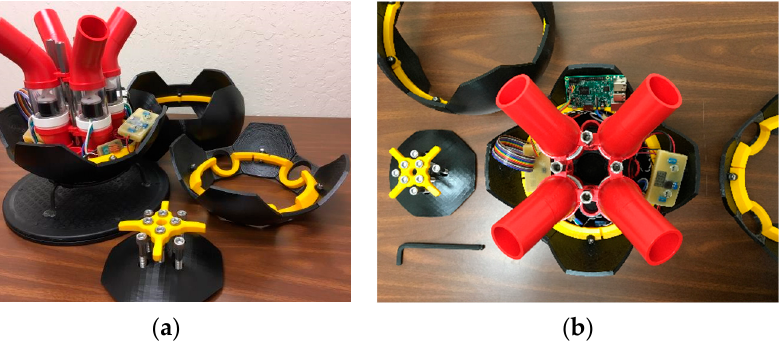
Figure 13. Propulsion core ( a ) Oblique ( b ) Top-down view. Note the four lower retention bolts